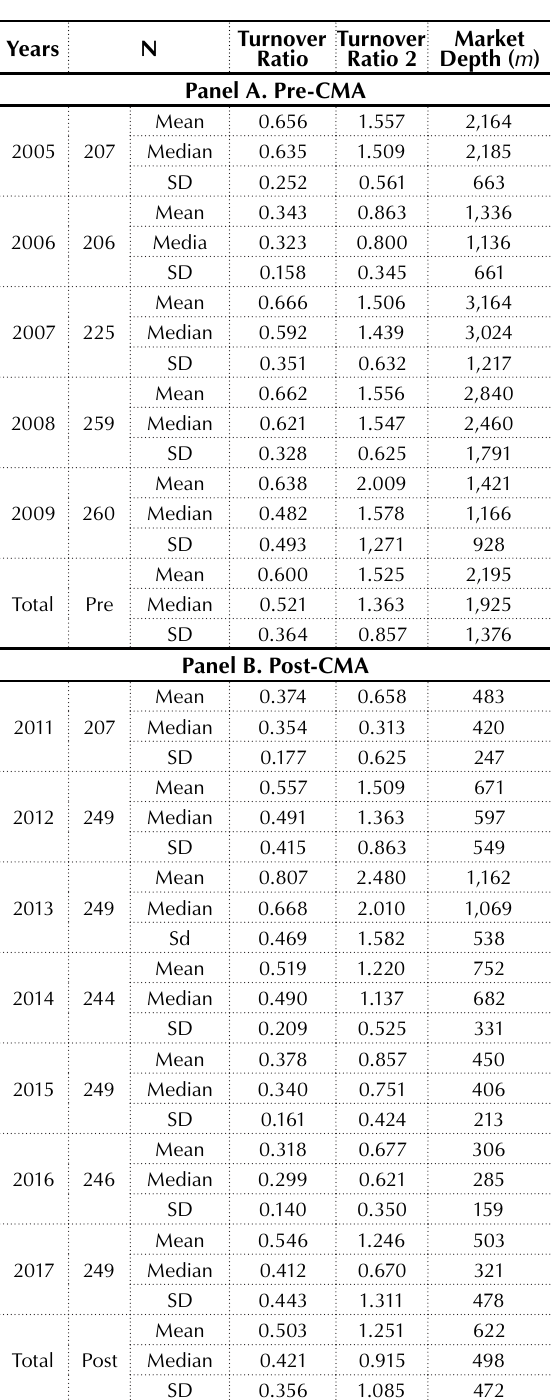
Table 3. Summary statistics of liquidity measures (trimmed basis) in pre and post CMA